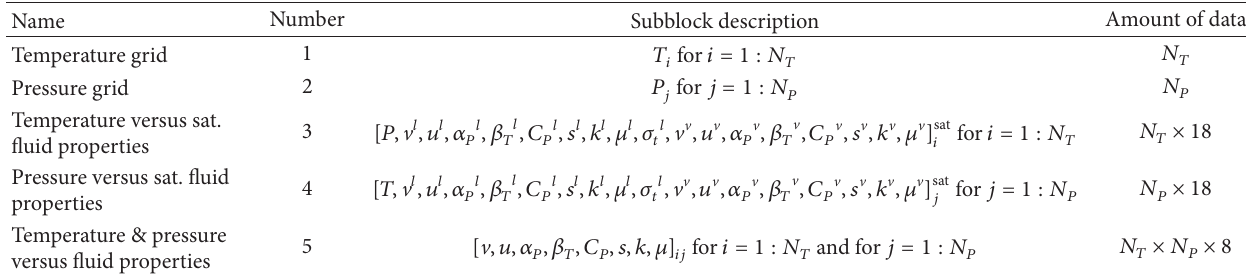
Table 2: Thermophysical properties data block structure description.